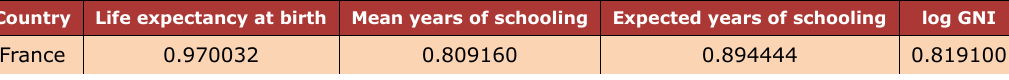
Table 2. Sample Decision